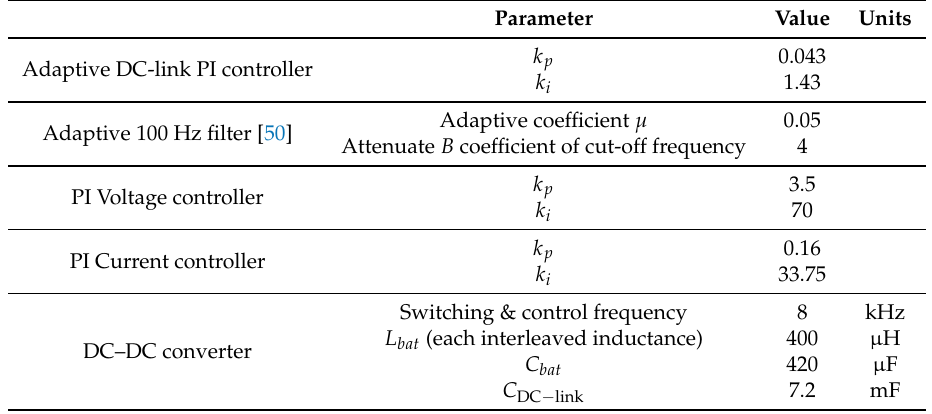
Table 1. Interleaved DC–DC (direct current–direct current) converter parameters. PI (Proportional Integral).